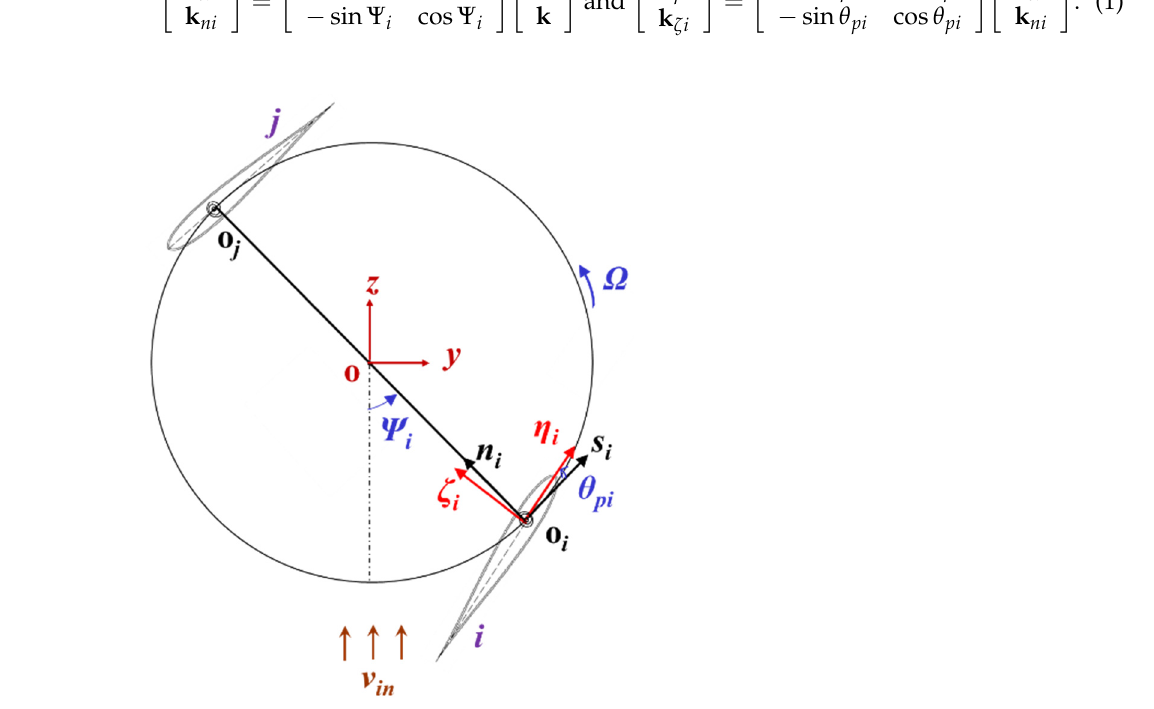
Figure 1. Rotating-airfoil model and coordinate systems.